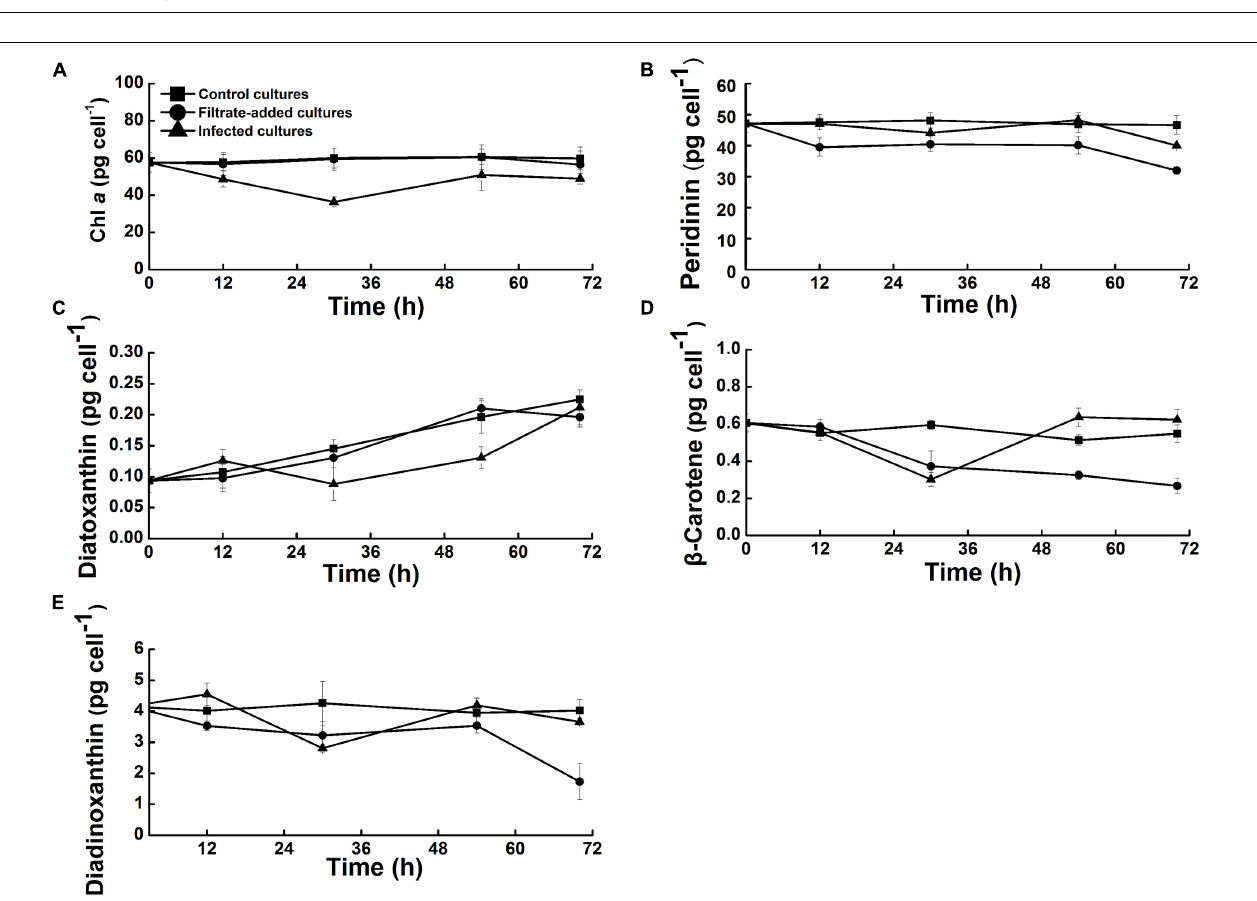
FIGURE 5 | Variations in the pigments of Akashiwo sanguinea during the course of infection by Amoebophrya sp. at a dinospore: host ratio of 10: 1. (A) Chlorophyll a . (B) Peridinin. (C) Diatoxanthin. (D) β -Carotene. (E) Diadinoxanthin. Error bars indicate the standard error.